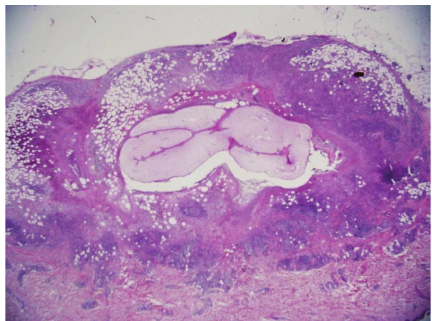
Figure 2: Microscopic view of cross-sections of the nematode (hematoxylin and eosin stain, original magnification 125x).